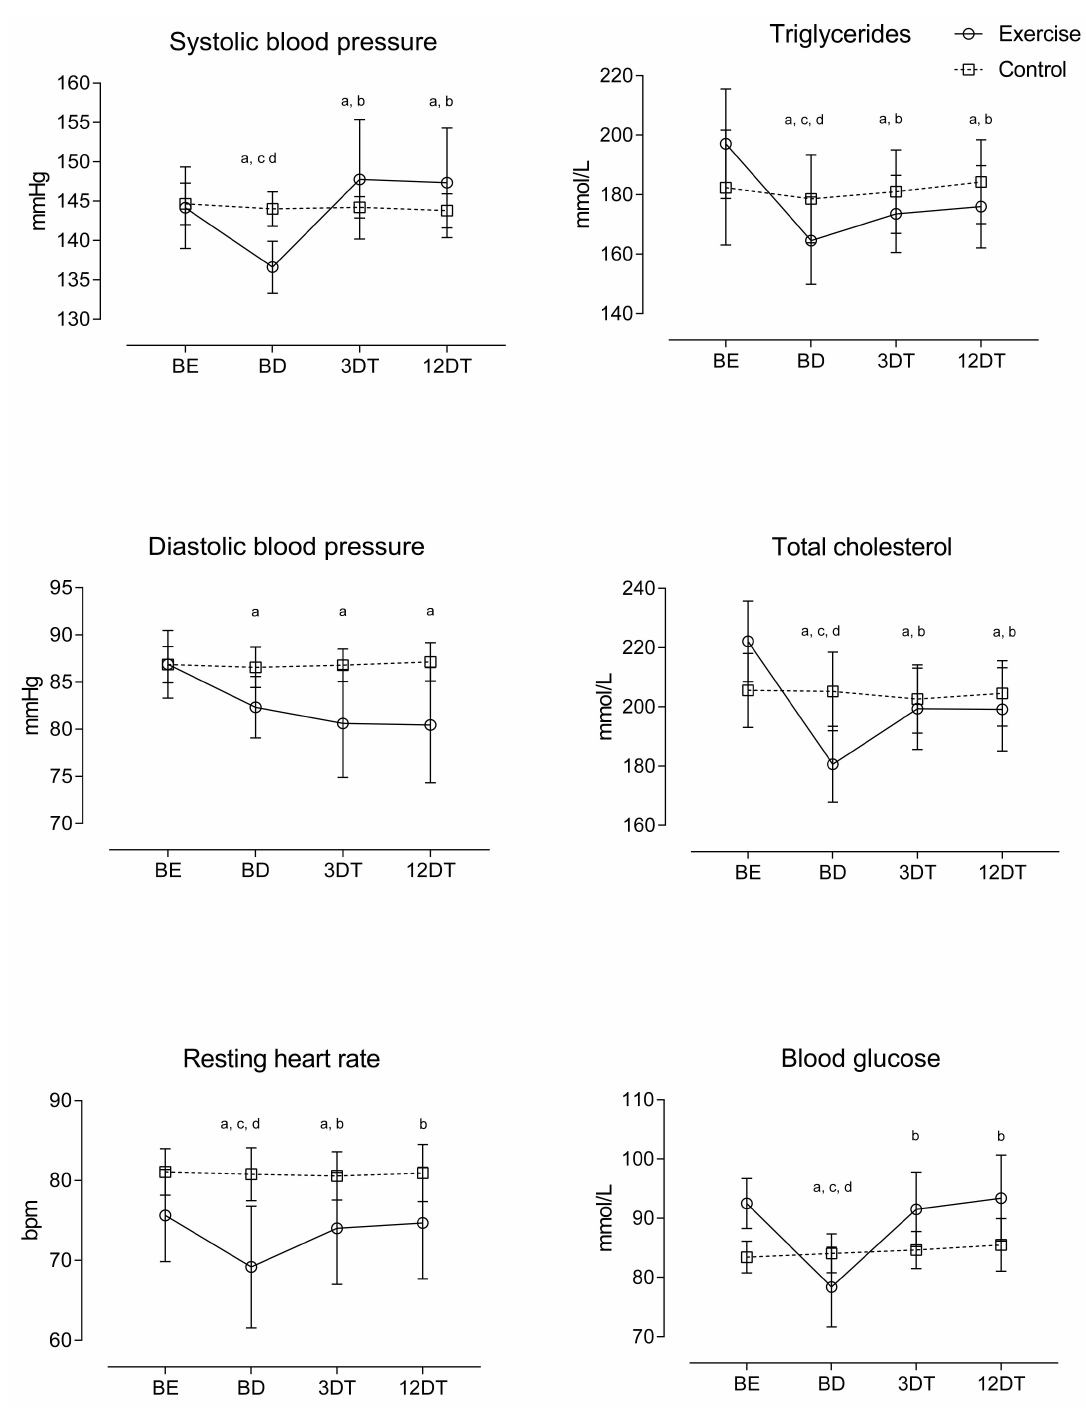
Figure 1. Relative changes in hemodynamic and lipidic profiles during the METP and the DT period; baseline (BE), after METP (BD), after three months of DT (3DT) and after 12 months of DT (12DT); millimoles per liter (mmol/L); a p < 0.05, significant difference between BEs for METP; b p < 0.05, significant difference between BDs for METP; c p < 0.05, significant difference between 3DTs for METP; d p < 0.05, significant difference between 12DTs for